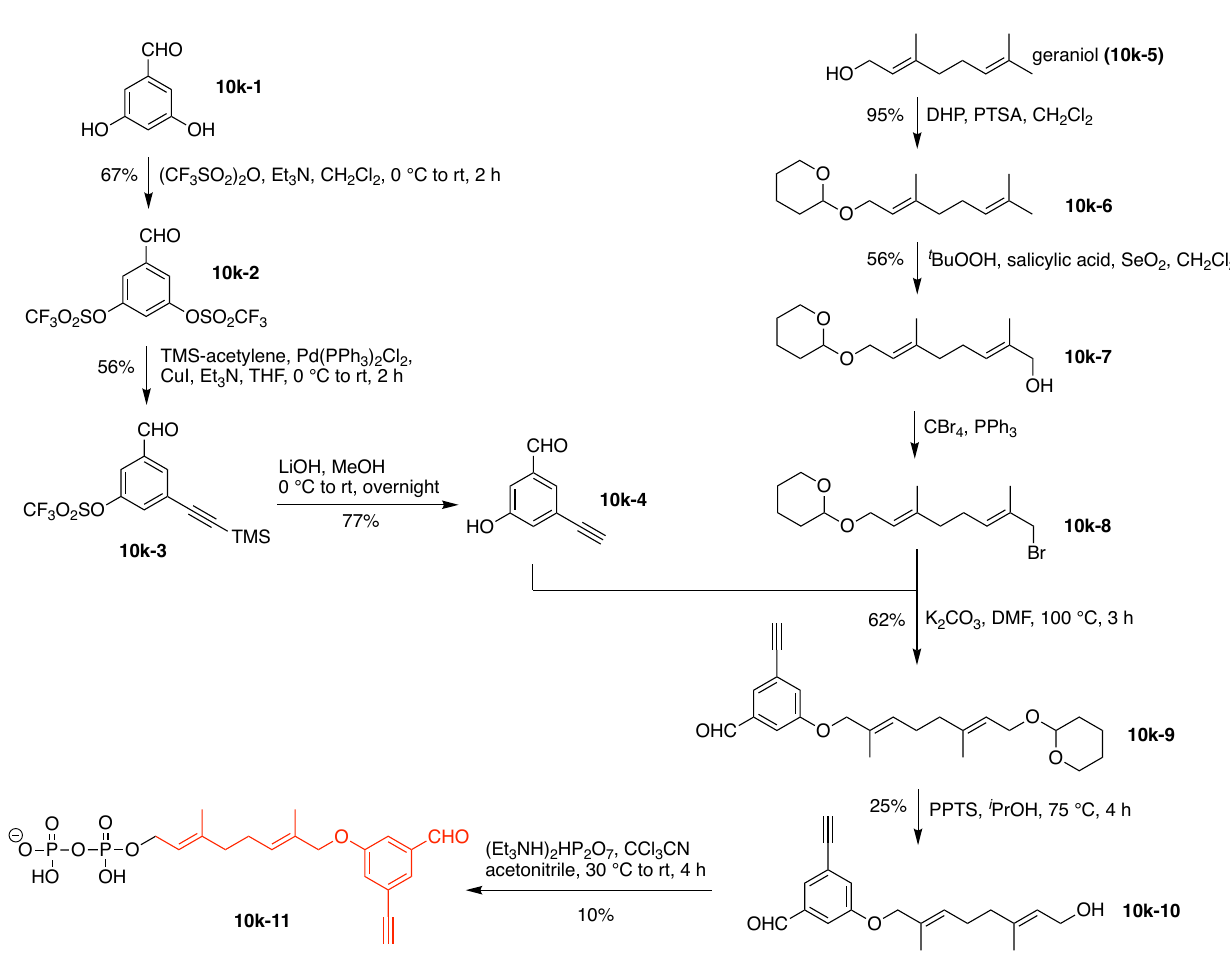
Figure 50. Synthesis of a triorthogonal scaffold comprised of a single benzene hub. The second hub was prepared beginning with 1,2-bis(2-aminoethoxy)ethane ( 10k-12 ). Boc protection of one amine followed by dialkylation with 5-bromovaleronitrile gave the dinitrile 10k-13 . Hydrogenation gave the mono-Boc-protected triamine 10k-14 , which was acylated with the side chain of N -protected glutamic acid O -methyl ester to give 10k-15 ; removal of the N -protecting group by hydrogenolysis followed by diacylation with MTX ( 10k-16 ) gave 10k-17 [266]. Treatment of 10k-17 to Boc removal under acid, coupling with 5-azidopropionic acid in the presence of 1-ethyl-3-(3-dimethylaminopropyl)carbodiimide hydrochloride (EDC), and saponification of the glutamic acid O -methyl ester gave the intermediate scaffold 10k-18 bearing two MTX groups and one azide (Figure 51). Assembling the A 2 BC compound relied on coupling of Unit B, a GFP containing tetrapeptide sequence ( 10k-19 , denoted as a CaaX box, CVIA in this case) at its C terminal, and the PFTase-ready substrate 10k-11 (Figure 52). The reaction was carried out in the presence of the water-soluble reducing agent 1,4-dithio- D -threitol (DTT). The reaction successfully incorporated both the aldehyde and alkyne groups to give the bifunctional (formyl, ethynyl) prenylated protein 10k-20 . Co-incubation of 10k-20 , aminooxy-TAMRA, and azido-bis(MTX) 10k-18 in the presence of m -phenylenediamine (mPDA) for 15 h gave the final target compound 10k . This work suggested that a protein bearing a C -terminal CaaX-box fusion is suitable for this strategy [263]. The triorthogonal reagent 10k-11 provides the protein with a hub for coupling with two orthogonal groups, which can be achieved in a one-flask procedure. In summary, this strategy expanded the property and function of the protein cargo by attachment with other functional groups for specific la- beling.